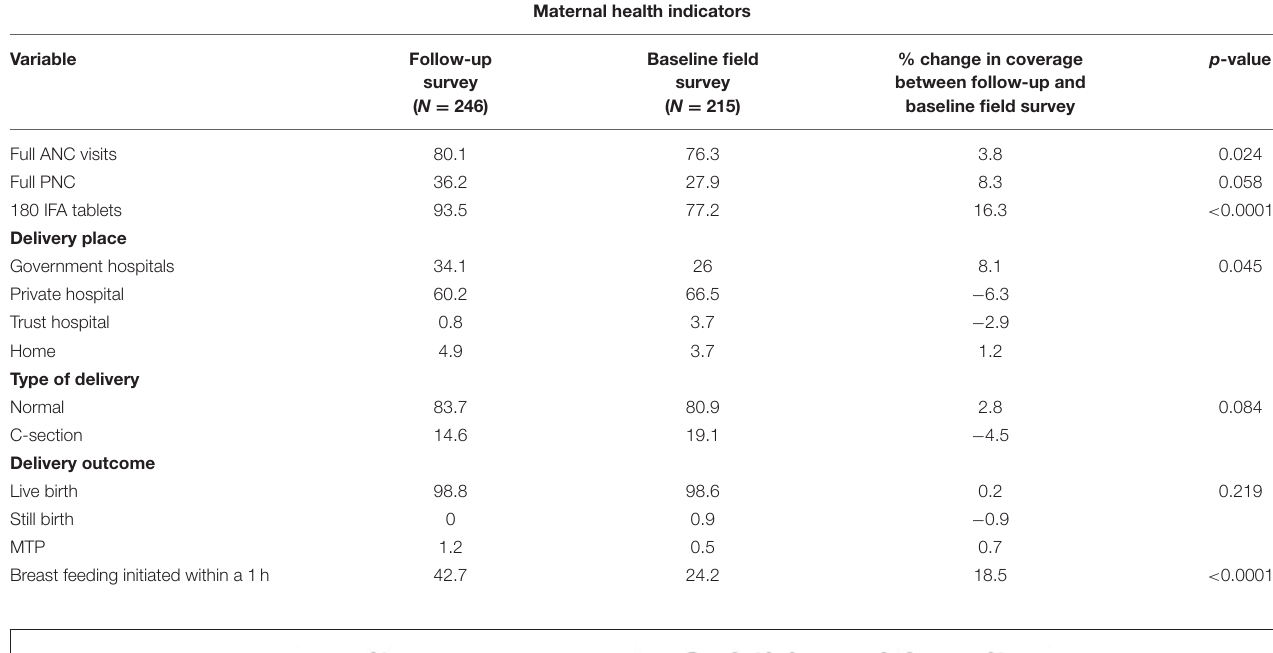
TABLE 1 | Coverage of various maternal health indicators.